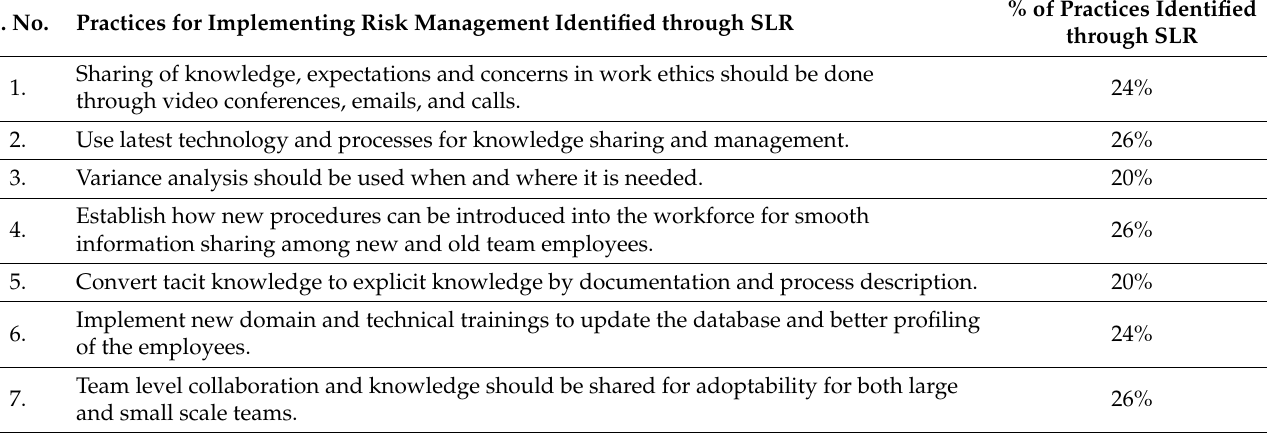
Table 17. Practices for implementing knowledge sharing